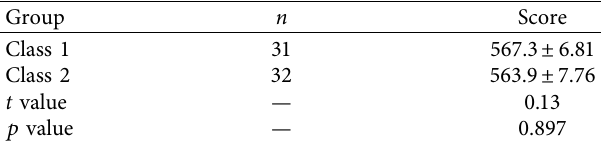
Table 1: Comparison of college entrance results between the two classes of students.